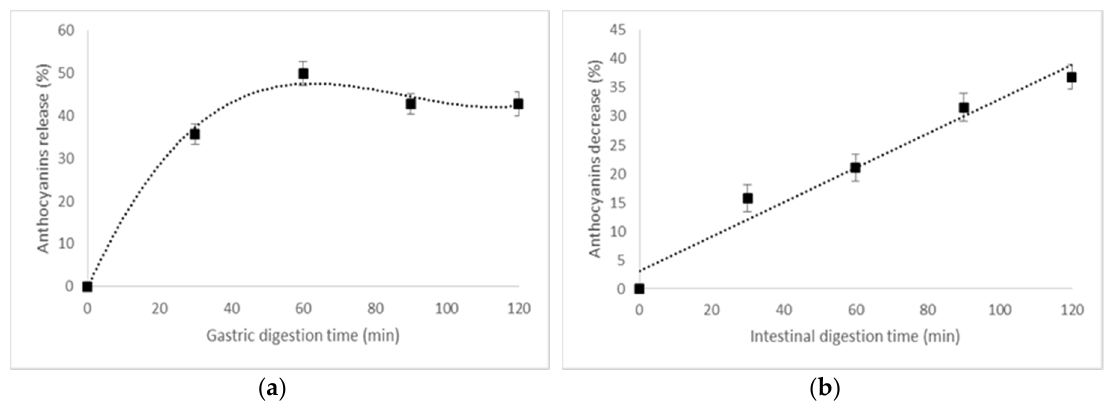
Figure 3. The in vitro digestibility pattern of anthocyanins in ( a ) a simulated gastric environment and in ( b ) intestinal juice.